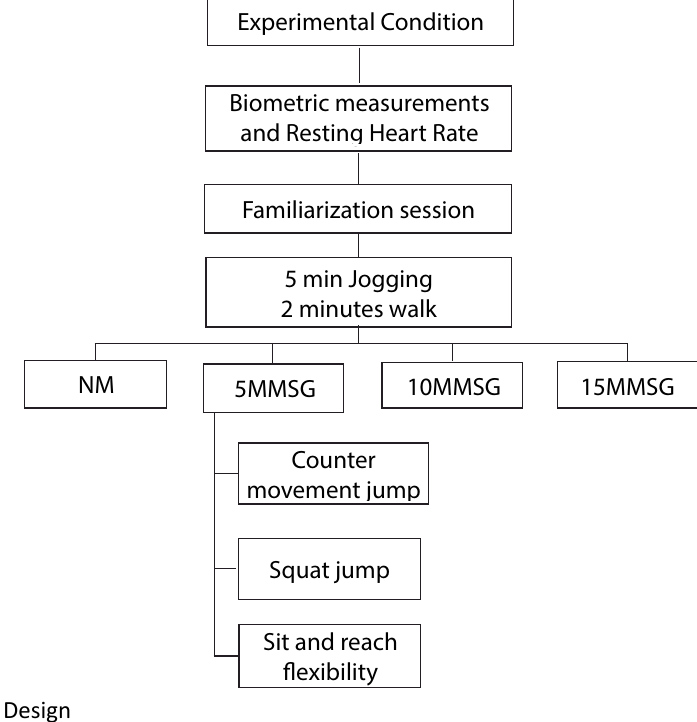
Figure 1. Experimental